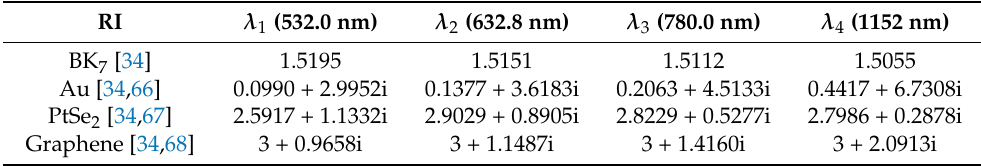
Table 1. RI of sensor materials at different